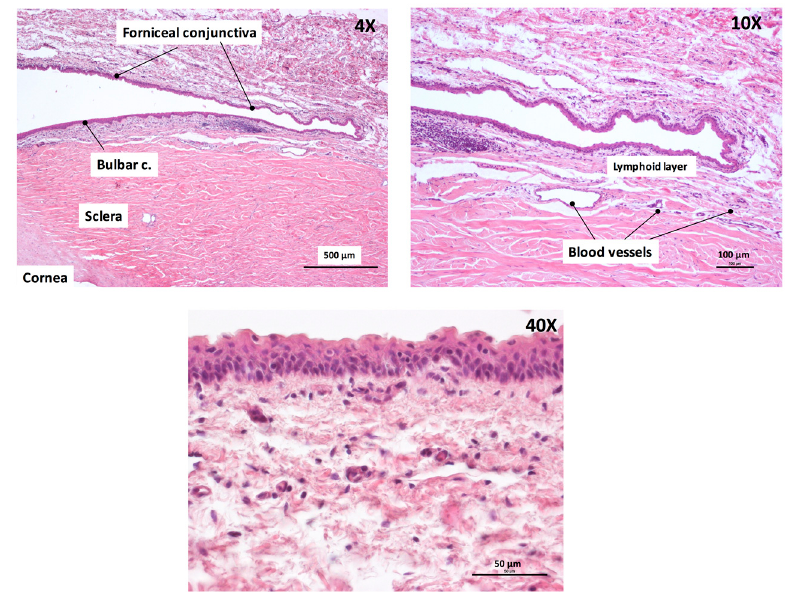
Figure A2. Histology of porcine conjunctiva at different magnifications.